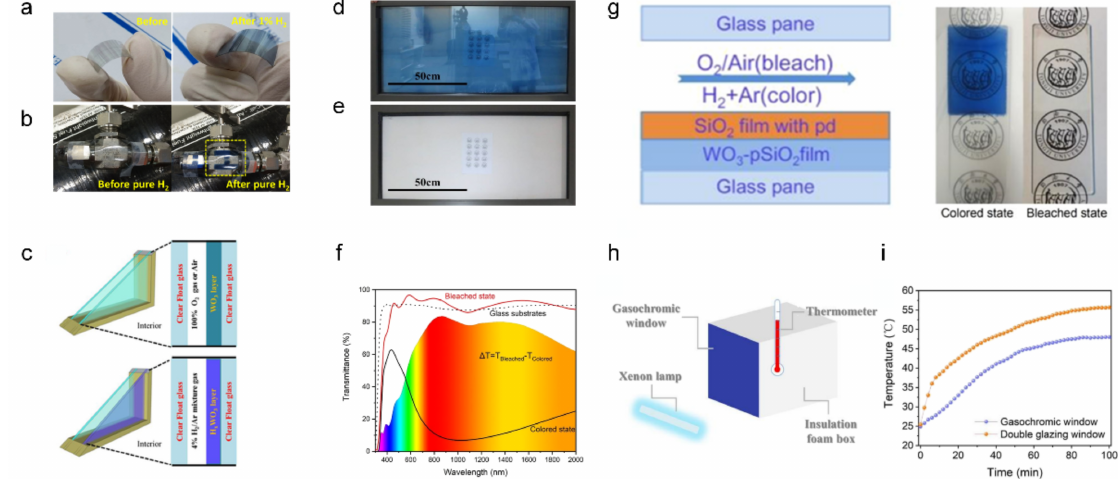
Figure 6. Gas sensor with chromic characterization (( a , b ) adapted with permission from ref. [62], copyright 2017 Elsevier, ( c ) adapted with permission from ref. [63], copyright 2017 IOP Publishing, ( d , e ) adapted with permission from ref. [64], copyright 2022 Springer, ( f – i ) adapted with permission from ref. [65], copyright 2021 American Chemical Society). ( a ) Photographic images of Pd–WO 3 films deposited on a flexible substrate for H 2 detection: ( left ) pristine Pd-WO 3 , ( right ) color-changed Pd-WO 3 under 1% H 2 gas. ( b ) Photographic images of the installed Pd-WO 3 films on a gas pipe carrying pure H 2 before and after injecting H 2 . ( c ) Configuration of a gasochromic smart window. A large-scale gasochromic smart window ( d ) under colored and ( e ) bleached states. The area of the smart window was 1.3 × 0.8 m 2 . ( f ) Transmittance change of the WO 3 -SiO 2 gasochromic films in the colored and bleached states. ( g ) Photographs of WO 3 -SiO 2 in colored and bleached states. A schematic illustration of the assembled window is shown below. ( h ) Schematic of the insulated box for sunlight absorbance measurement. ( i ) Heating curve of the sunlight absorbance